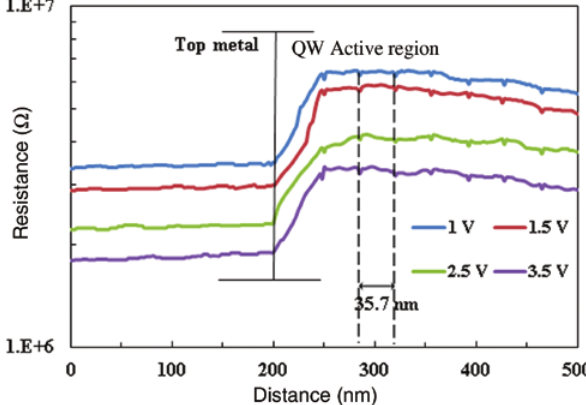
Figure 8: 1D SSRM-measured resistance profile near the top metal-semiconductor active region interface of V843 at different DC tip biases of 1.0, 1.5, 2.5, and 3.5 V.